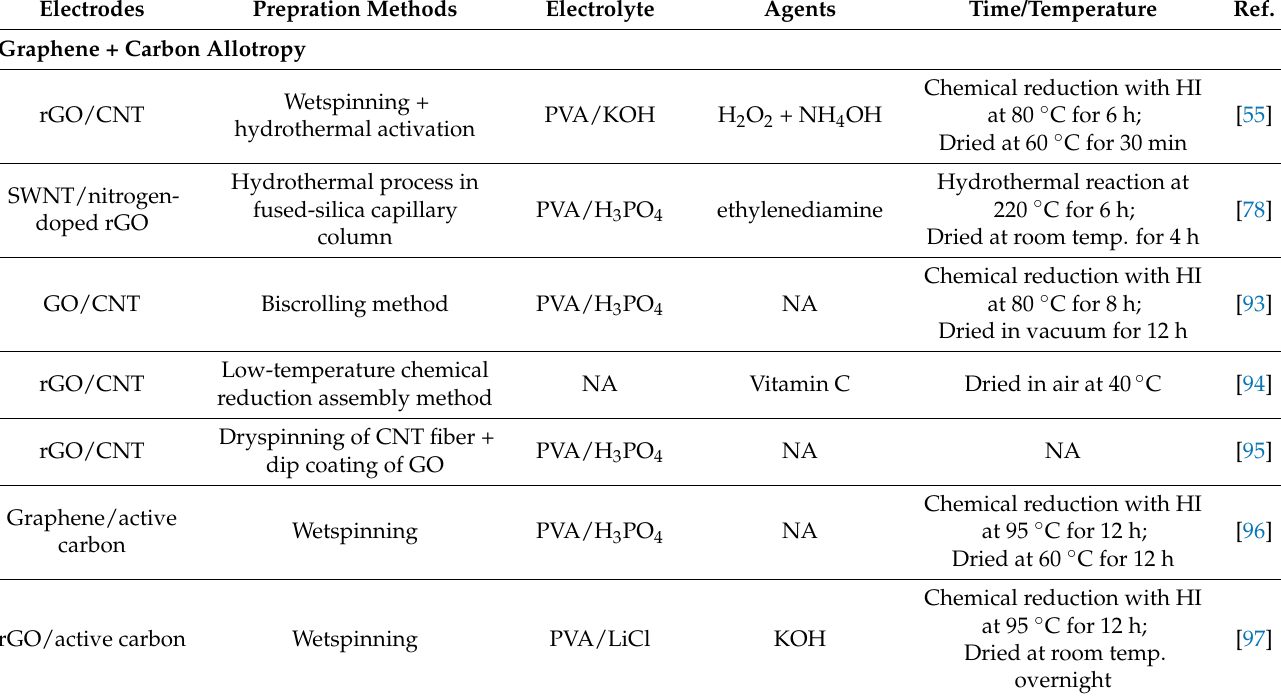
Table 1. Preparation of different graphene-based composite